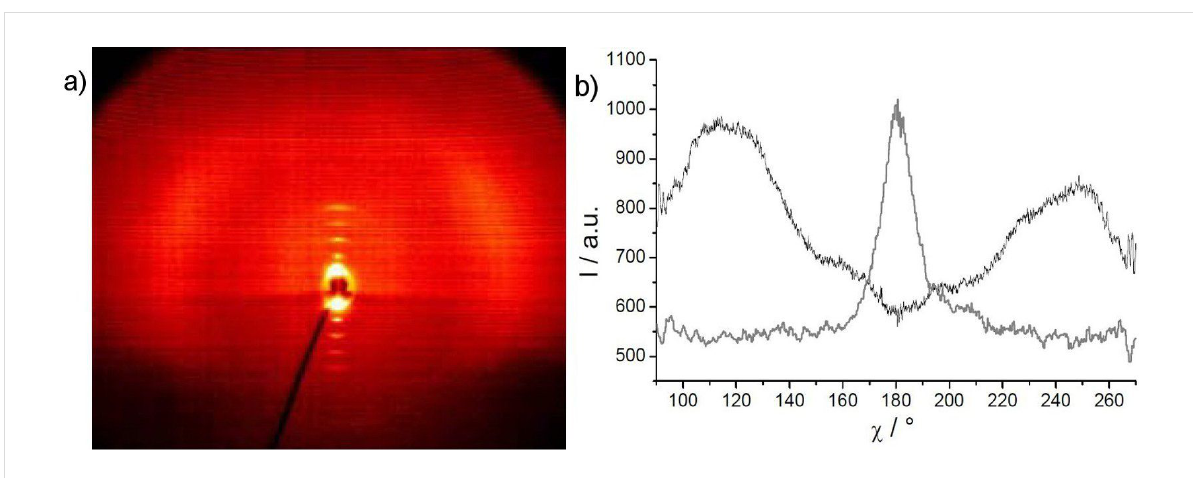
Figure 11: a) 2D X-ray pattern of a surface-aligned sample of compound OH 3b at 160 °C ( lower part of the pattern shadowed by the heating stage); b) χ -scan for the diffuse scattering (black line), compared to the position of the layer reflections on the meridian (grey line).